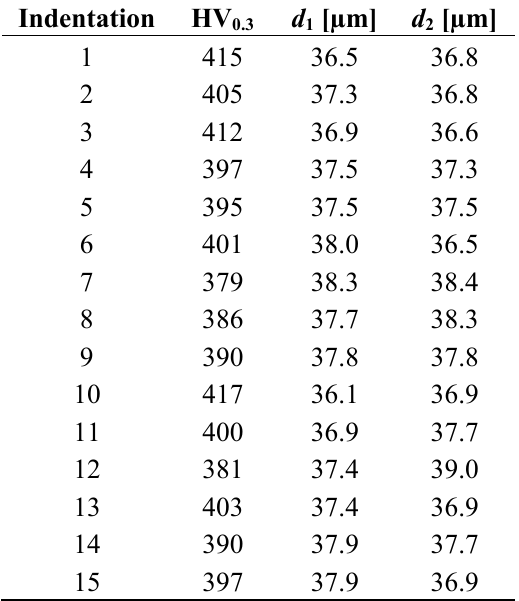
Table 3. Results of micro-hardness for specimen in condition 4.